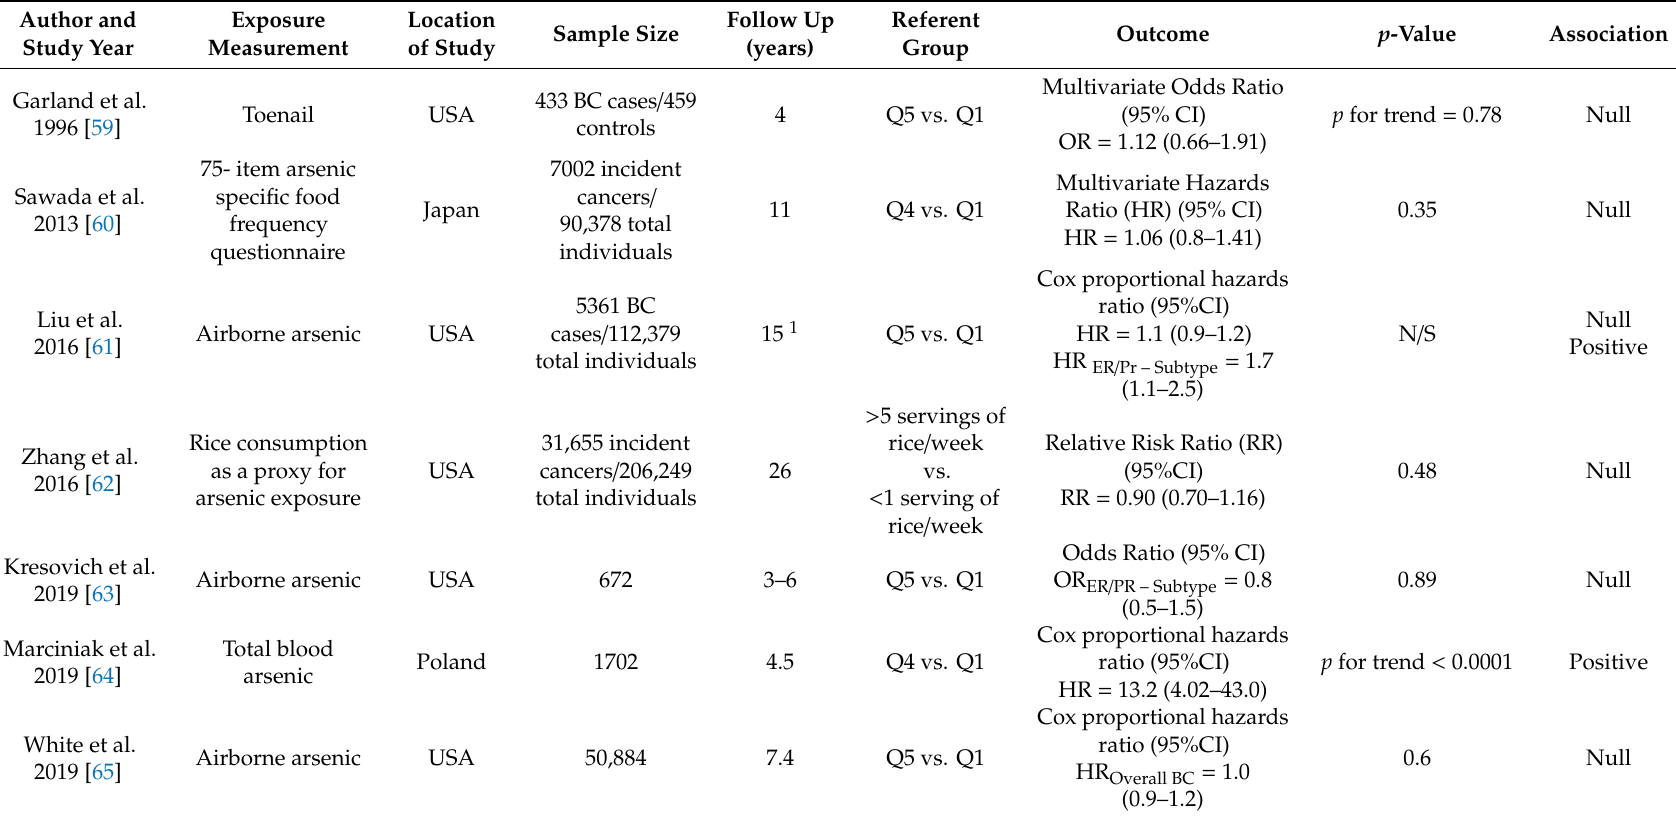
Table 4. Summary of prospective studies investigating the relationship between arsenic exposure and breast cancer